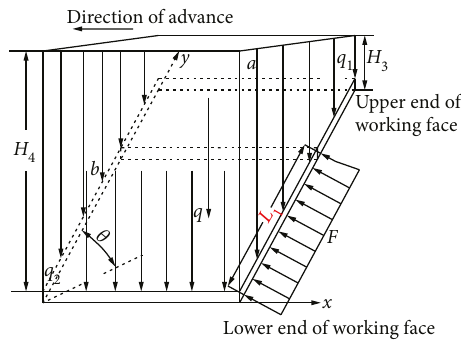
Figure 5: A working face model for the mechanical analysis of the main